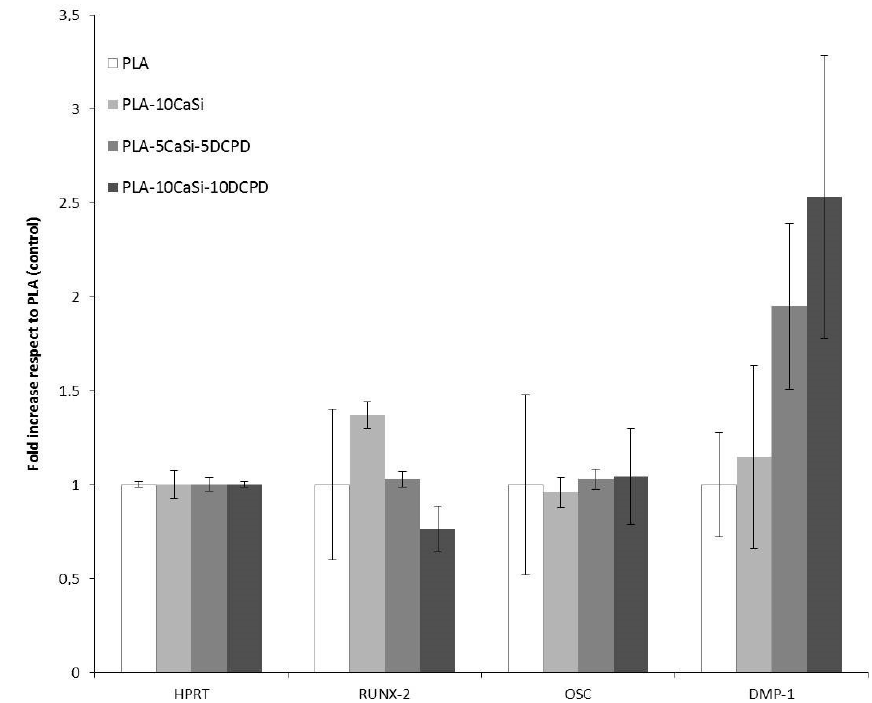
Figure 13. qPCR of hPCy-MSCs after 21 days of culture on mineral doped scaffolds. Histograms indicate fold increase in mRNA levels of hPCy-MSCs cells grown on PLA-10CaSi, PLA-5CaSi-5DCPD and PLA30 10CaSi-10DCPD, with respect to PLA control. Error bars indicate standard deviation of mean values.